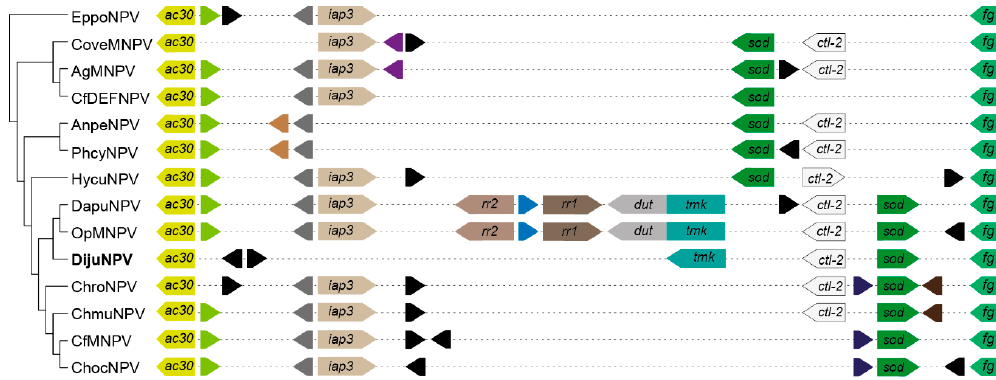
Figure 5. Syntenic genomic context chart containing both iap3 and tmk orthologs in DijuNPV-related species. We show the genomic context together with the phylogeny among the species. The arrowhead shape represents gene orientation, and similar colors represent ortholog genes. Autapomorphies are colored black, and dashed lines concatenate the genes.